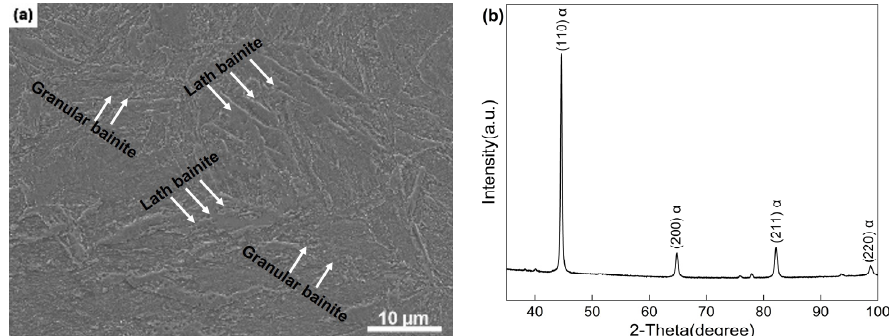
Figure 1. ( a ) The microstructure of the original sample. ( b ) X-ray diffraction of original